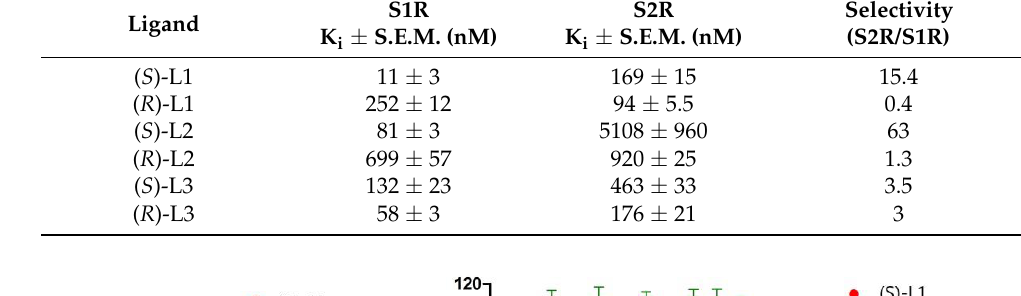
Table 4. Sigma-1 and Sigma-2 receptor binding parameters and S2R/S1R selectivity for a panel of ligands.